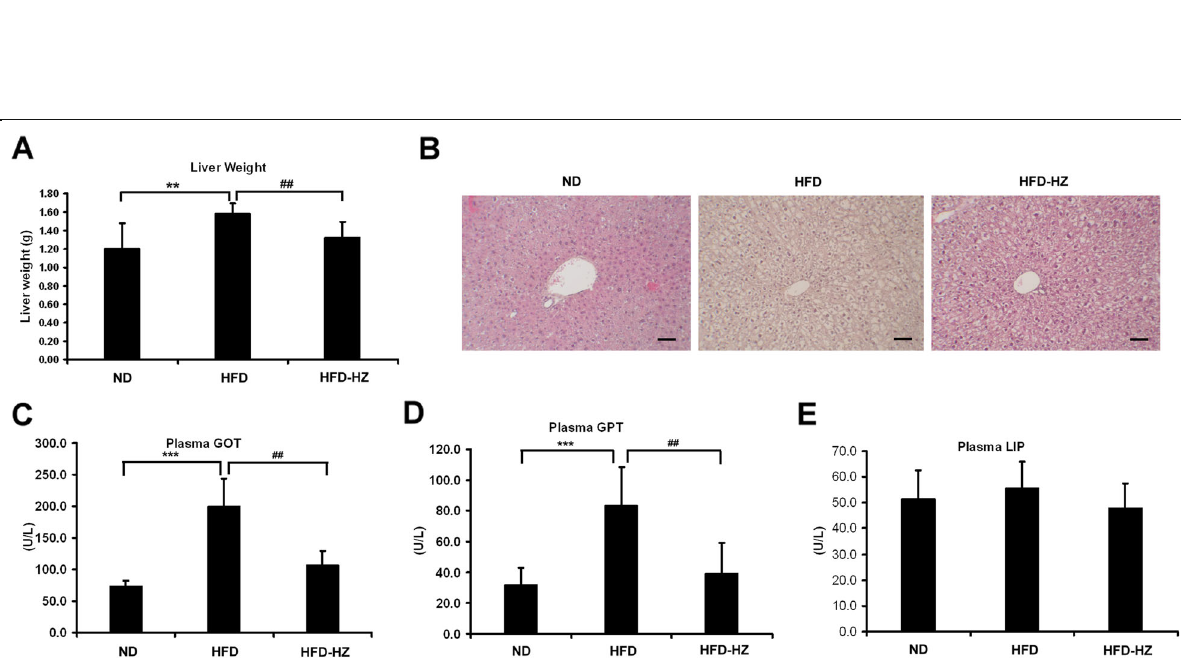
Fig. 6 The effect of HZ extract treatment on hepatic steatosis-related markers in HFD-fed C57BL/6 J mice. a Changes in liver weight. b Hematoxylin and eosin staining of the transverse liver (original magnification × 200). The scale bar is 100 μ M. c and d The plasma levels of the hepatic lipotoxicity markers GOT and GPT. e The levels of plasma lipase (LIP). Data are shown as means ± SEM (n = 10 per group). ND vs. HFD: * p < 0.05; ** p < 0.01; *** p < 0.001. HFD vs. HZ: # p < 0.05; ## p < 0.01; ### p <